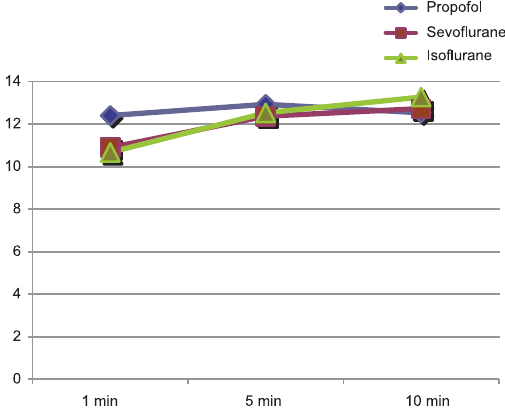
FIGURE 1. White fast tracking scoring system, assessment preformed 1, 5 and 10 minutes post extubation